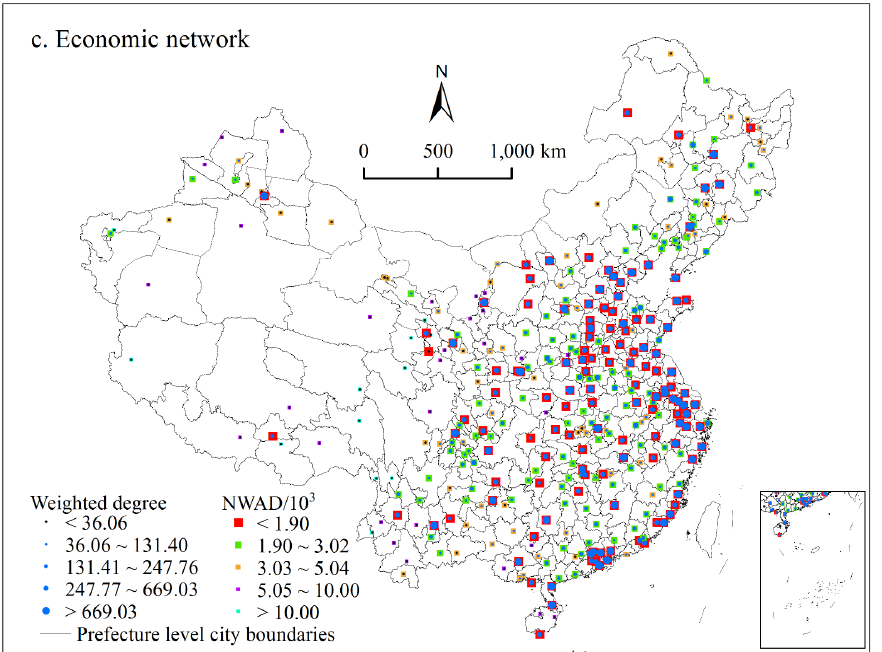
Figure 4. Weighted degree and neighbor-weighted average degree (NWAD) of networks: ( a ) infor- mation network; ( b ) transportation network; ( c ) economic network.